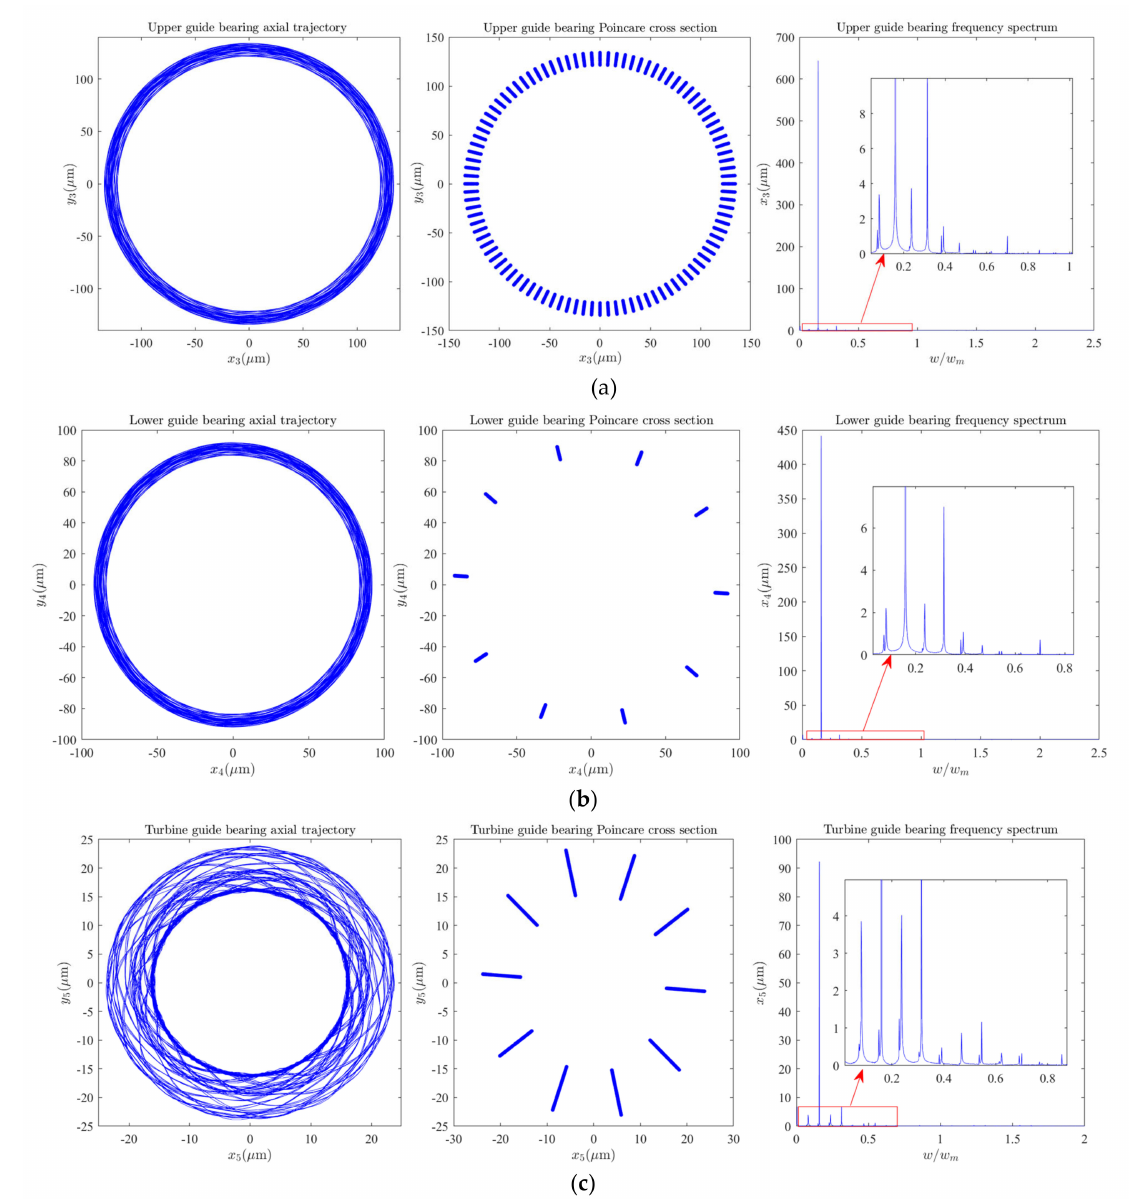
Figure 4. Dynamic characteristic of guide bearings: ( a ) Upper guide bearing dynamic characteristics, ( b ) Lower guide bearing dynamic characteristics, ( c ) Turbine guide bearing dynamic characteristics.